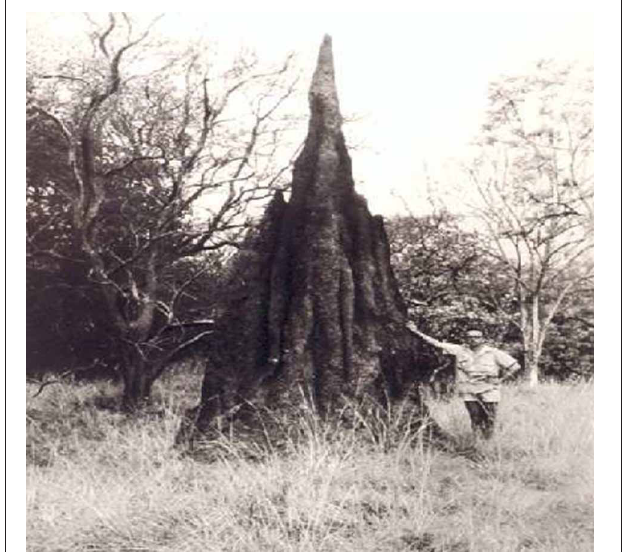
FIGURE 1 | A termite nest. Taken from “An Introduction to Swarm Intelligence Issues” by Gianni Di Caro, Swarm-part-1.pdf. Individual termites will interact as they lay down pheromone. When a critical mass of termites and pheromone is reached, the termites gather together to begin building the termite nest. Individual termites through their interactions construct the termite nest without instruction from an architect.